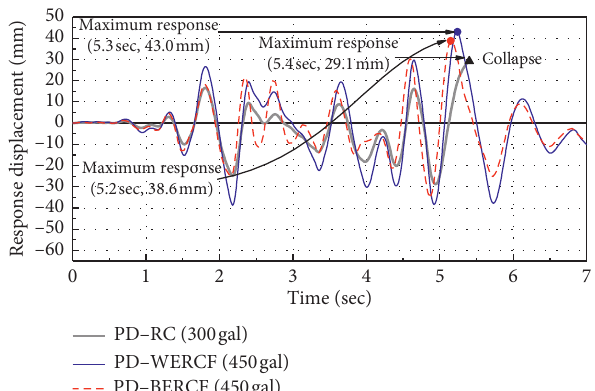
Figure 18: Response displacement-time history relationships of the control specimen and ESRCF-strengthened specimens during pseudodynamic testing at 450 gal. Table 7: Maximum response displacement at 300gal and the decrease thereof for test specimens in comparison with the control.